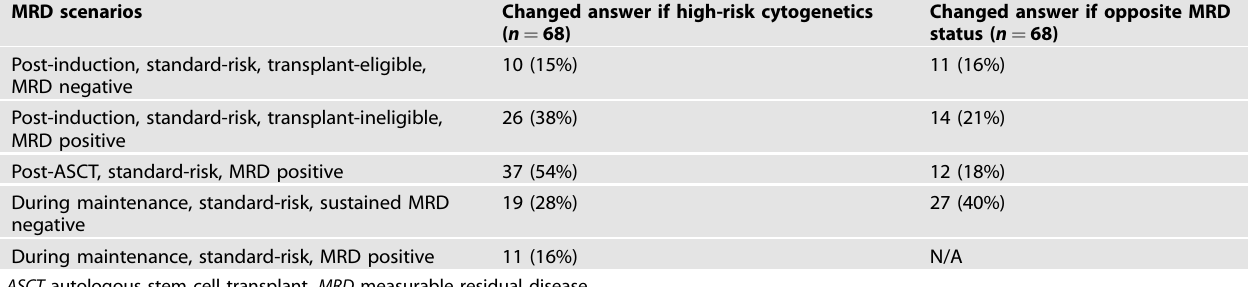
Table 2. Responses to different clinical scenarios in fi rst-line therapy for multiple